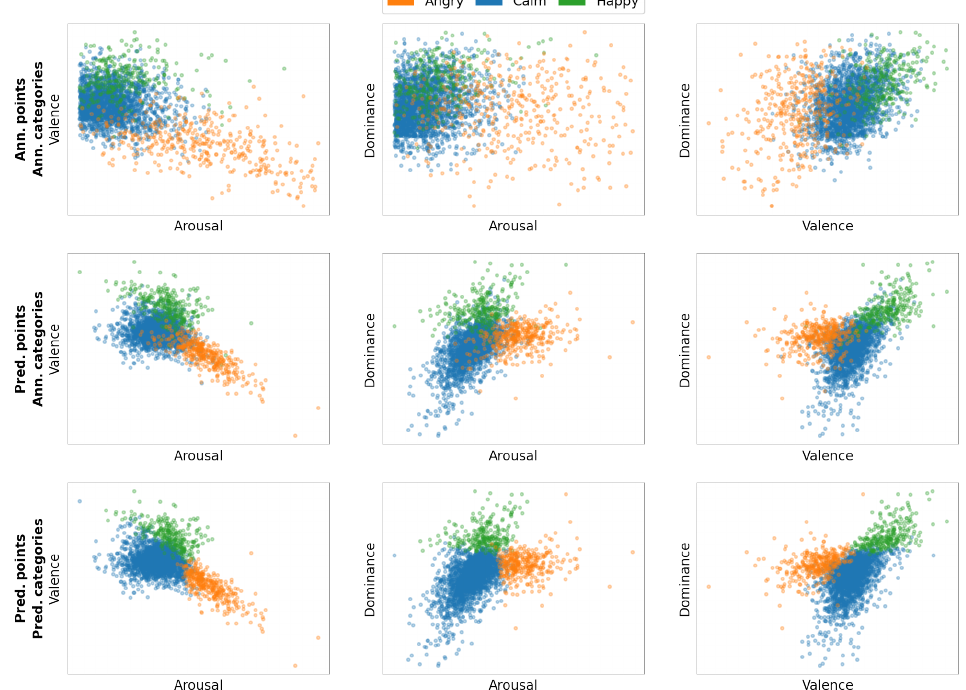
Figure 3. Correlation between the VAD and categorical models, according to both the annotated and predicted